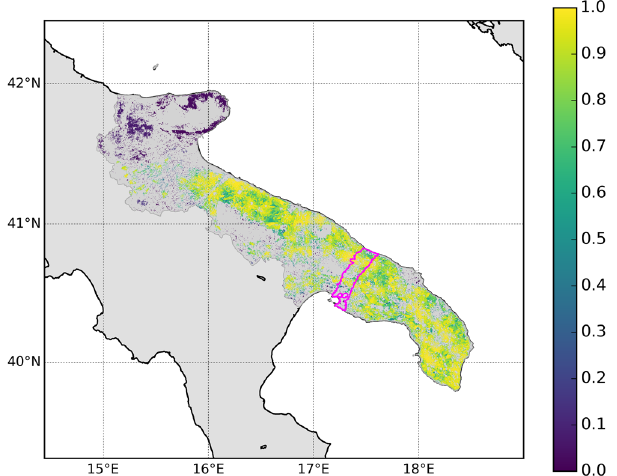
Figure 4. Relative importance of olive orchards as spreaders of Xylella fastidiosa in Puglia. Colors show the probability (averaged over 1000 simulations and rescaled between 0 and 1) of an orchard becoming infected with X. fastidiosa in simulations of the bacterium becoming endemic in the Puglia region. Dark grey areas are other land cover types in Puglia, while light grey areas were not analyzed. The magenta line delineates the current buffer zone that is intensely monitored and aims to prevent X. fastidiosa from spreading north. The map was generated using the Python Basemap Matplotlib Toolkit